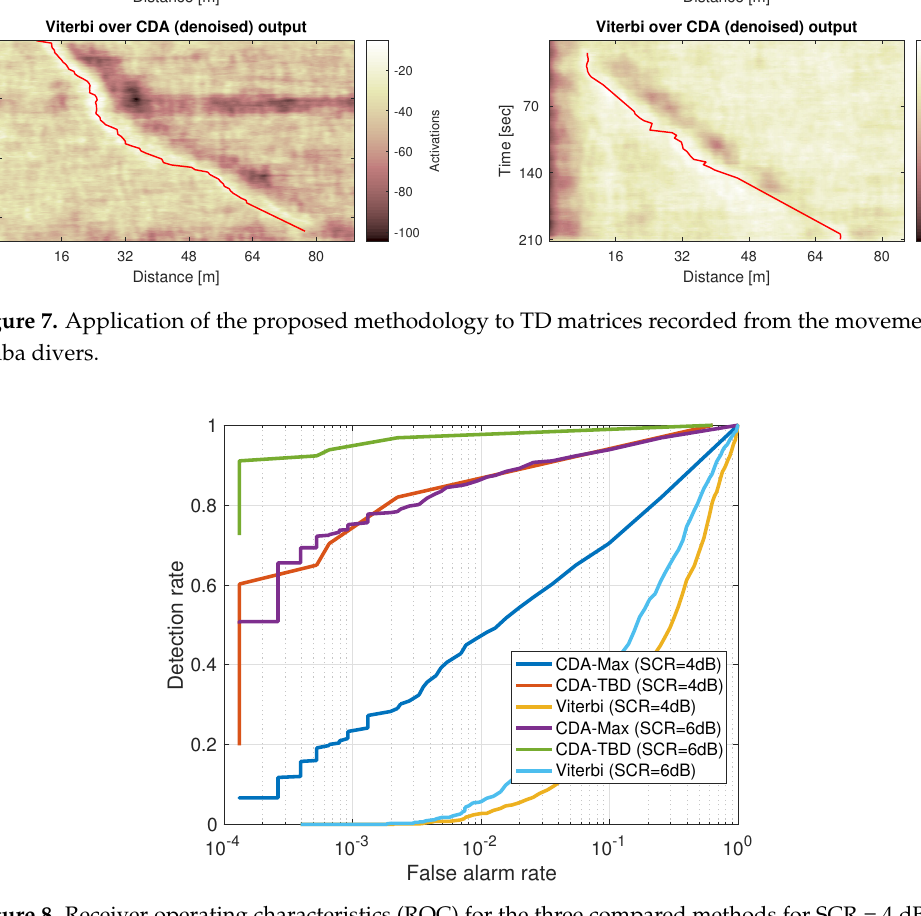
Figure 8. Receiver operating characteristics (ROC) for the three compared methods for SCR = 4 dB and 6 dB. Results shows a favourable trade-off between detection and false alarm rates for